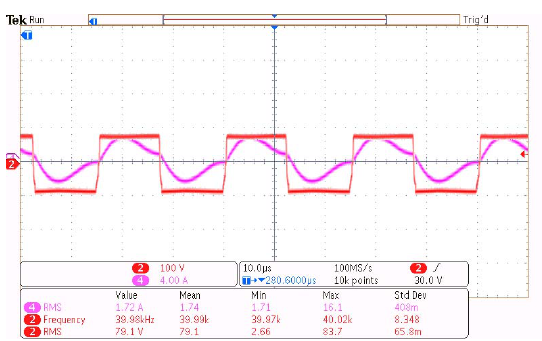
Figure 20. Tracking of constant power.